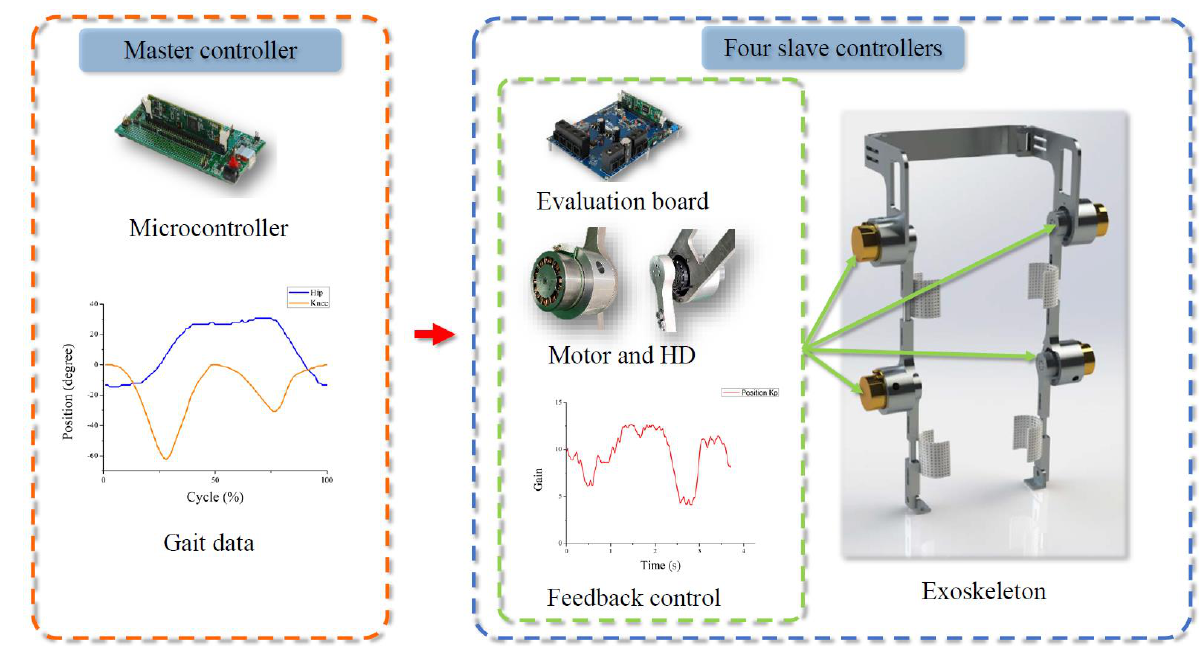
Figure 9. Master and slave motor-driven system of the LLRE-II.